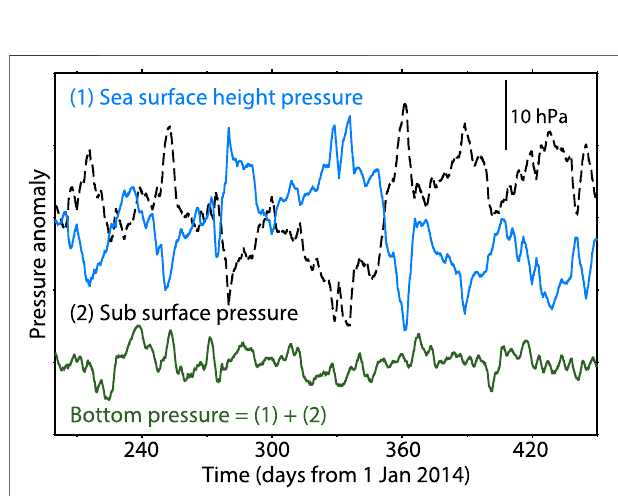
FIGURE 4 | Pressure variations derived from sea surface height (light blue), integration below static sea level (black dashed), and both combined (dark green). This is an example of LOBS4 ( – 39.1201 ° N, 178.9815 ° E) at the Hikurangi Trough, which is calculated from HYCOM.